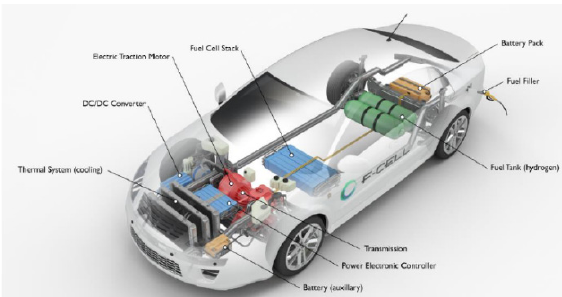
Figure 1. Conceptual scheme of a fuel cell vehicle (FCV) provided by a H 2 pressurized tank [2].